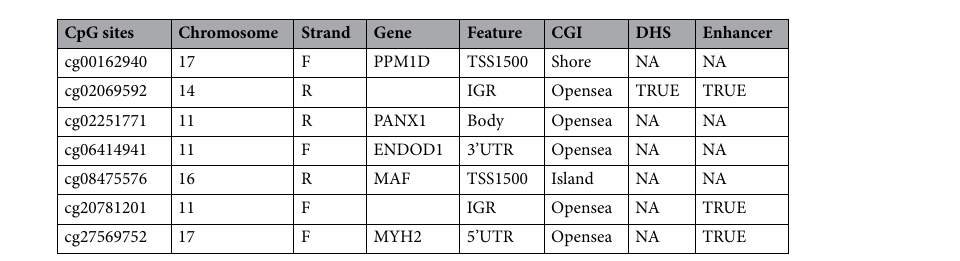
Table 2. Overview of included CpG sites in terms of location, gene annotation, and gene function of the 11 CpG-sites in the risk signature. CGI CpG island, DHS DNase-I-hypersensitive sites, PPM1D